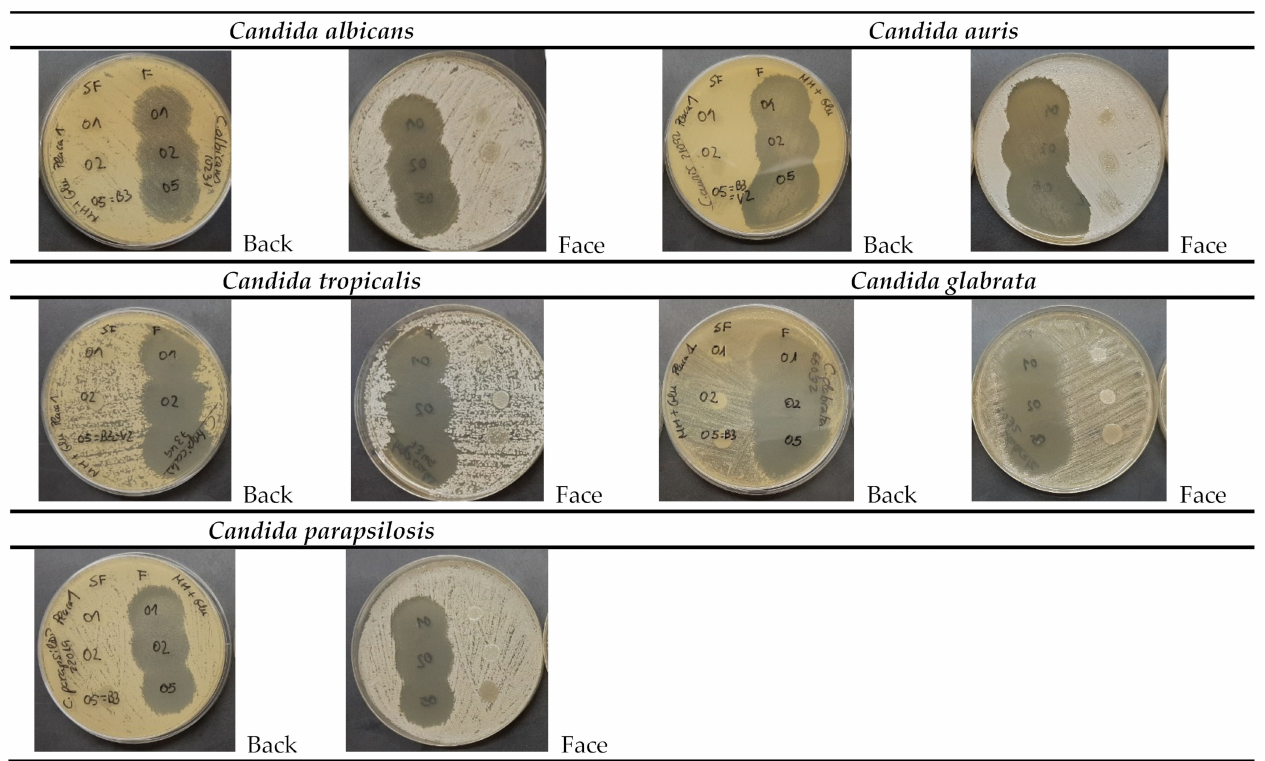
Figure 9. Inhibition zones produced by formulations with and without 0.5% caspofungin against yeast C. albicans ATCC 10231, C. auris DSM 21092, C. tropicalis ATCC 7349, C. glabrata ATCC 66032, and C. parapsilosis ATCC 22019. In a frontal view (face), the Caspofungin formulations marked “F” are seen on the left of the plate, and the excipients O1, O2, and O3 marked “SF” on the right, whereas in a view from the reverse (back) of the plate, positions are